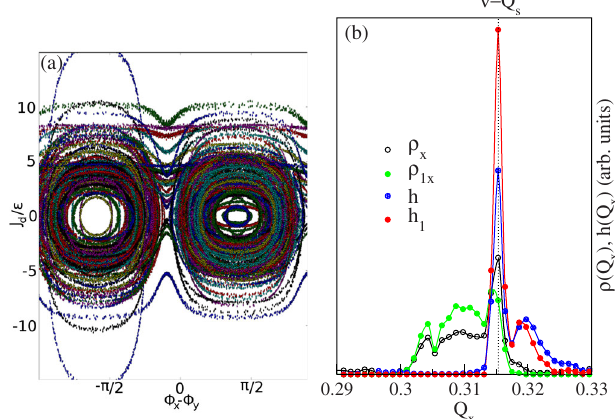
FIG. 4. Coupling resonance, q ¼ 7 . 94 . (a) Poincare plots, J d − Φ versus Φ , for randomly selected particles belonging to the x y 0.5% largest changing energy particles. Most of these particles are trapped in the resonance islands. (b) The horizontal tune FIG. 3. (a) Bunch tune footprint at coupling resonance for Þ (black), the Q Þ (blue) density ρ ð Q shifted tune density h ð Q x t x q ¼ 7 . 94 . The white dot corresponds to the bare betatron tunes. P P Þ (green) with and the one-tune-per-particle tune density ρ 1 ð Q Δ J ¼ ð J − J Þ of the 0.05% and 0.2% x (b) Þ for the 0.5% si si si initial i ∈ S i ∈ S the corresponding Q shifted tune density h 1 ð Q t x largest increasing energy particles versus turn number, normal- Þ and h ð Q Þ are strongly largest changing energy particles. h ð Q 1 x x ized by the product of emittance and the number of the particles ¼ ν − Q peaked at the resonant mode tune Q , showing mode- x s in the sum. (c) The same as (b) but for the largest decreasing ¯ x term [see Eq. particle resonance via the BJ d energy particles. (d) Tune footprint for the 0.5% largest changing energy (increase and decrease) particles. Large part of the spectral − 2 Q ¼ 0 , with the weight is along the resonance line 2 Q x y horizontal tune well below ν − Q . The color dimension scale in s (a) and (d) differs by one order of magnitude.